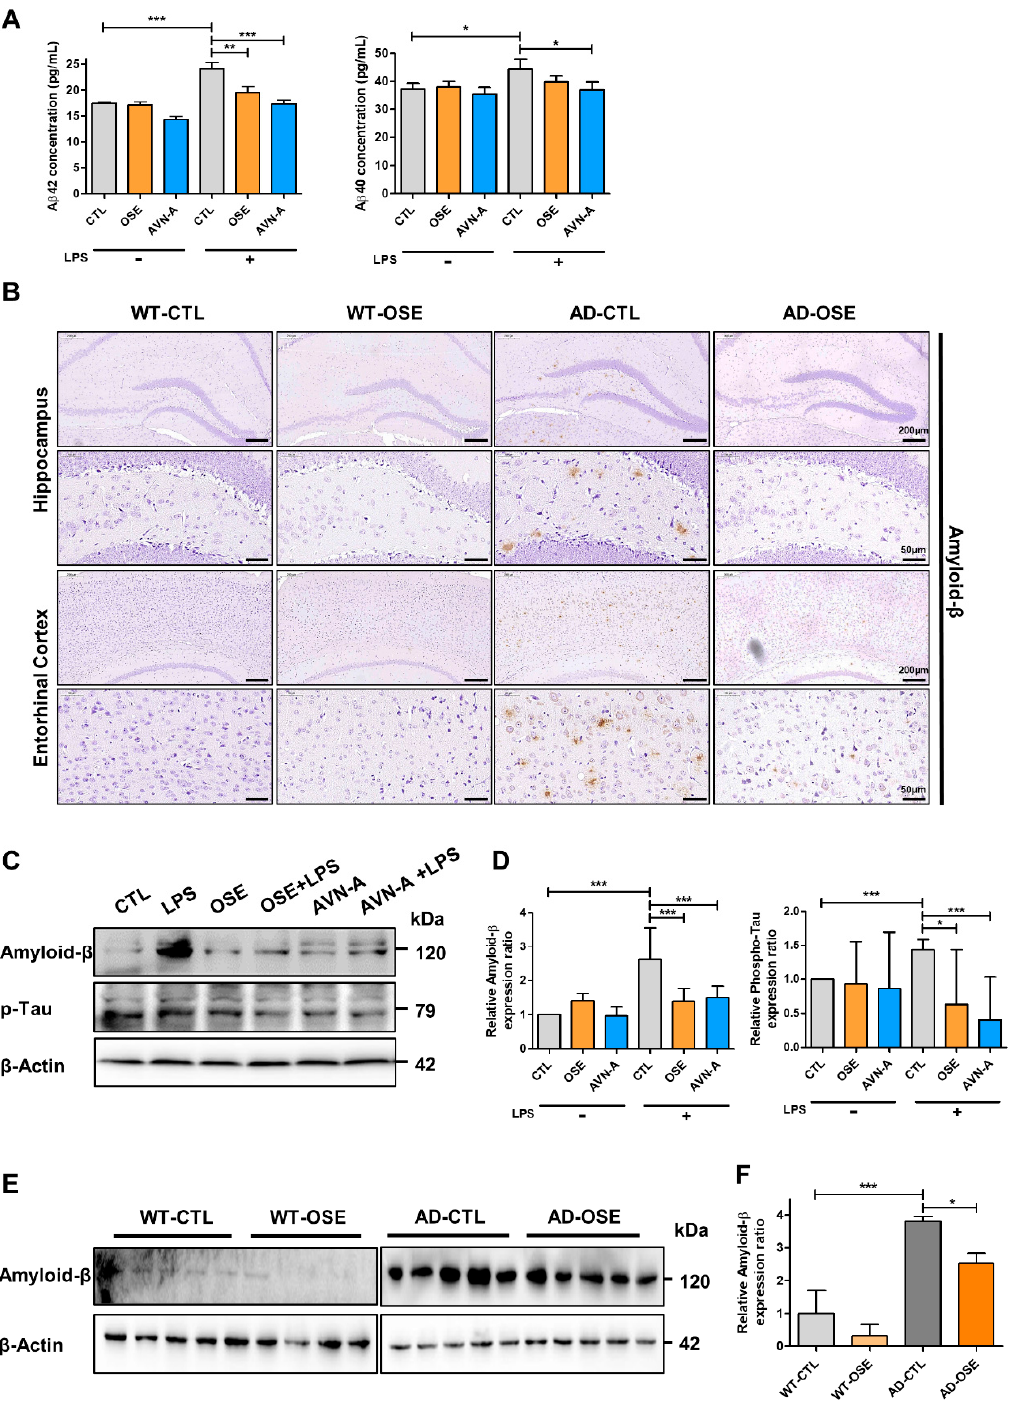
Figure 2. OSE and AVN-A exposure lowers the deposition of A β in Tg-5xFAD AD mice. ( A ) The A β 42 and A β 40 in the cell lysate were measured by color metric ELISA assay. ( B ) Representative images of A β deposition in the CA1 region of the hippocampus and entorhinal cortex of Tg-5xFAD AD and WT mice. ( C , E ) Cell lysates (30 µ g) of each treated cell line and in vivo were immunoblotted (IB) with indicated antibodies. ( D , F ) Validation of differentially expressed proteins were done by Western-blot analysis. * p < 0.05, ** p < 0.01, *** p < 0.001.